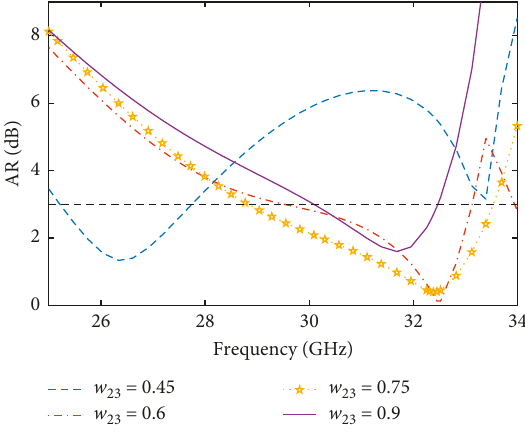
Figure 9: Effects of various w